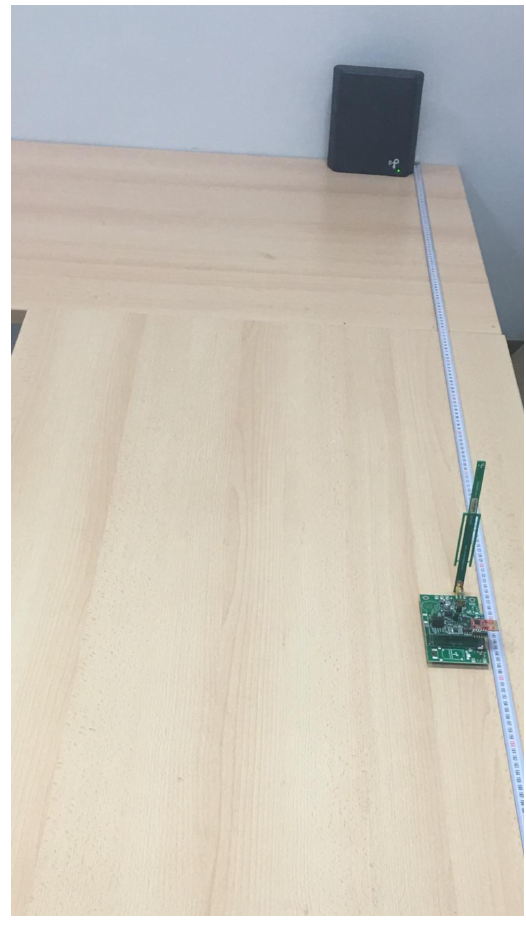
Figure 4. Experiment setup.